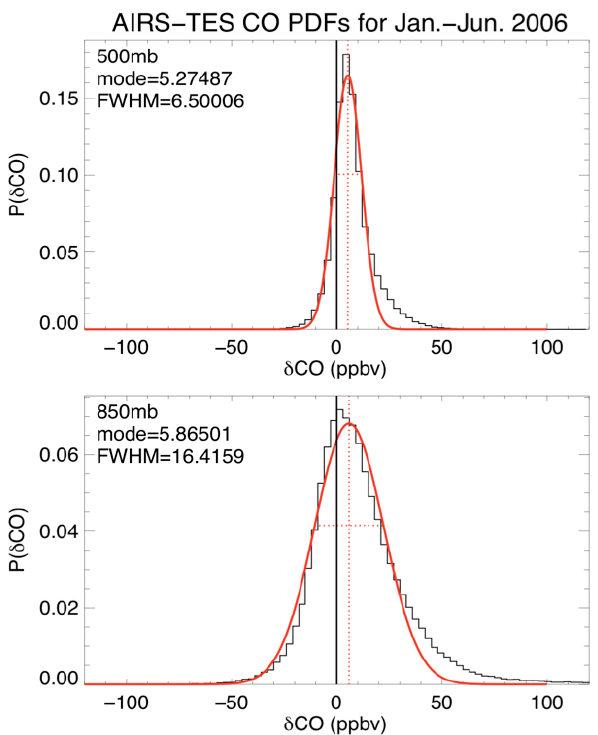
Figure 7. Fig. 7. The PDF and the Gaussian fits of the differences between collocated AIRS OE CO and TES CO convolved to AIRS AKs at 500 and 800hPa, respectively, globally for the period of 1 January to 31 June